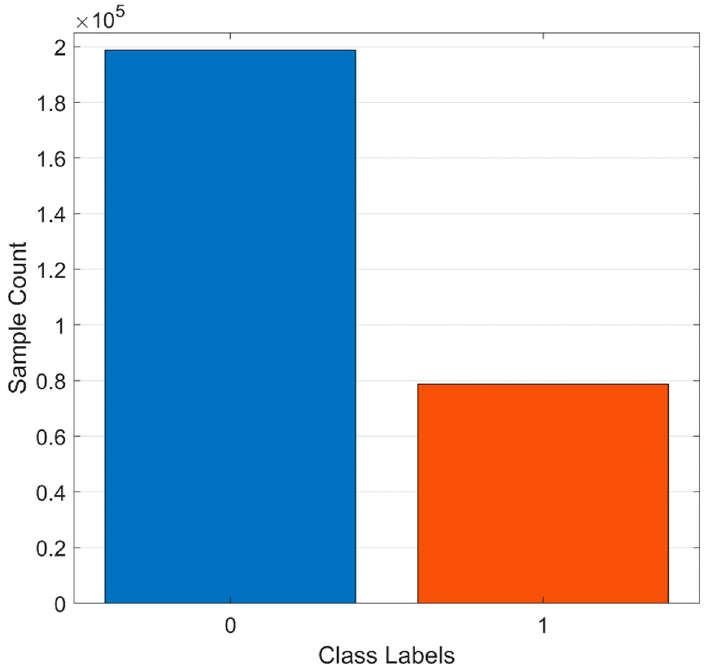
Figure 3. Distribution of the categories in the target variable. ‘0 ′ and ‘1 ′ indicate the absence or presence of invasive ductal carcinoma, respectively.